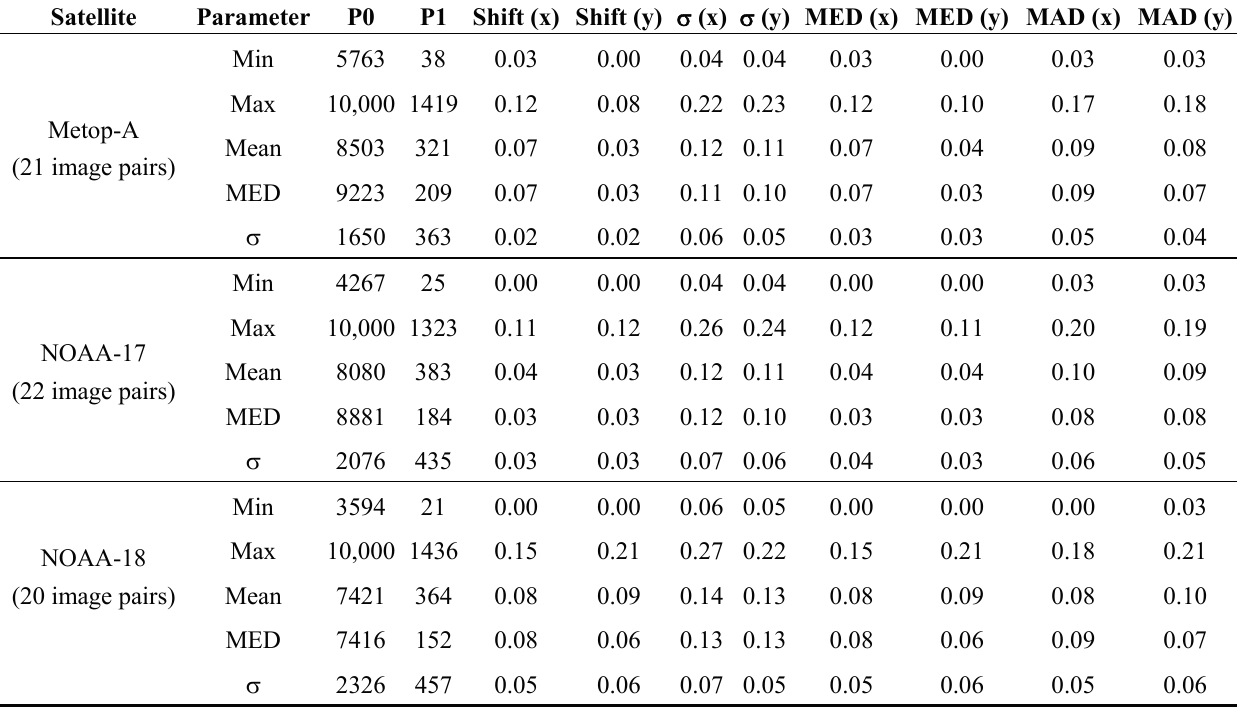
Figure 16. Image space shifts obtained from the matching of the Band-1 ( left ) and Band-4 ( right) images with Band-2 image acquired from NOAA-18 on 27 November 2008. The axes denote the image coordinates. Table 6. BBR accuracy evaluation results between AVHRR Bands 1 and 2; statistical summary from the point matching results of all images for the three satellites. The given statistics are in pixels and are derived from the absolute